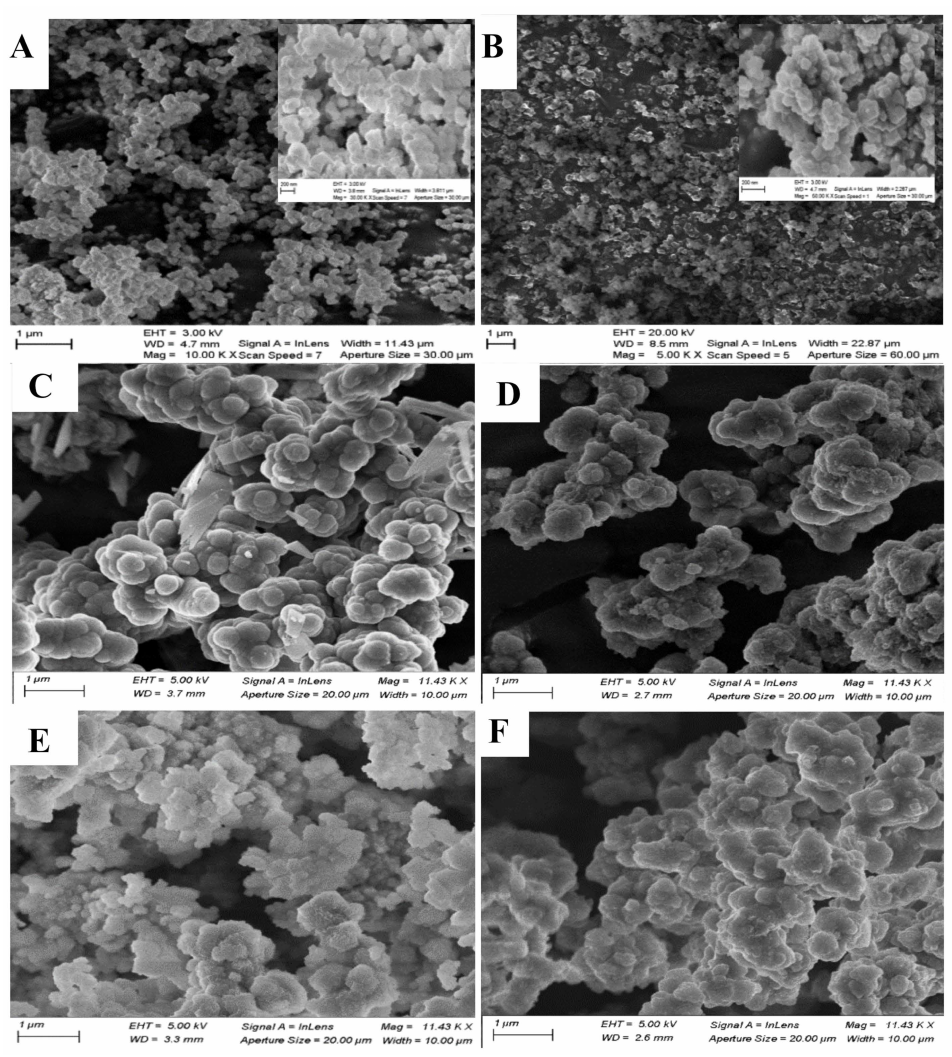
Figure 4. SEM image of ( A ) M A , ( B ) M B , ( C ) M A -U, ( D ) M B -U, ( E ) M A -UT, and ( F ) M B -UT. 3.1.4. Microwave Plasma Atomic Emission Spectrometry (MP-AES) and the Surface